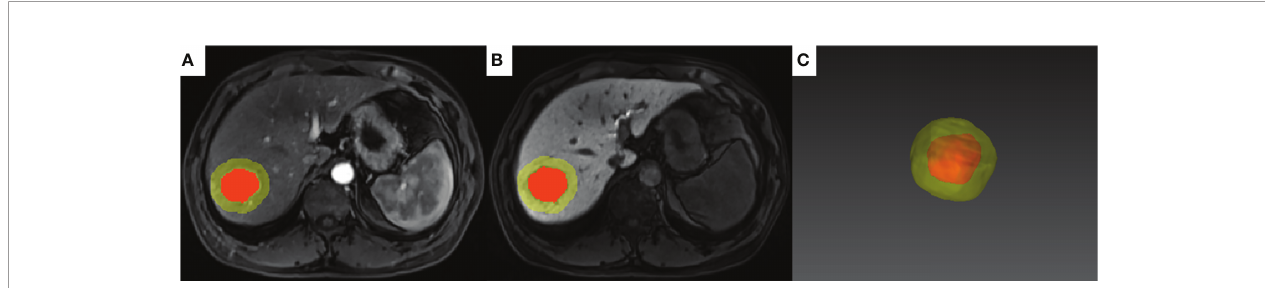
FIGURE 3 | A representative case of tumor segmentation with MVI (+) with 10-mm dilation from the tumor margin. The red area indicates the intratumoral region and the yellow area indicates the peritumoral region on the arterial phase (A) and hepatobiliary phase (B) . (C) 3D effect of the tumor segmentation with 10-mm